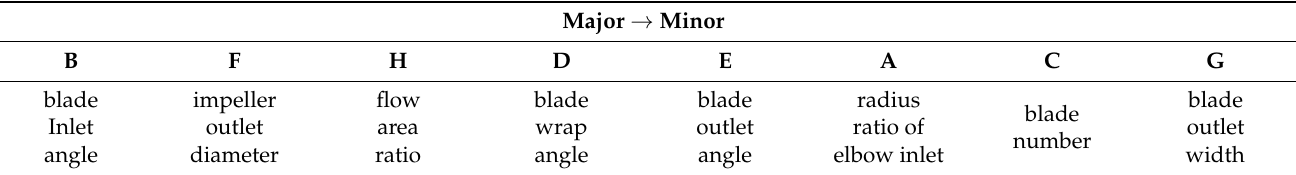
Table 9. Sequence among factors affecting pump